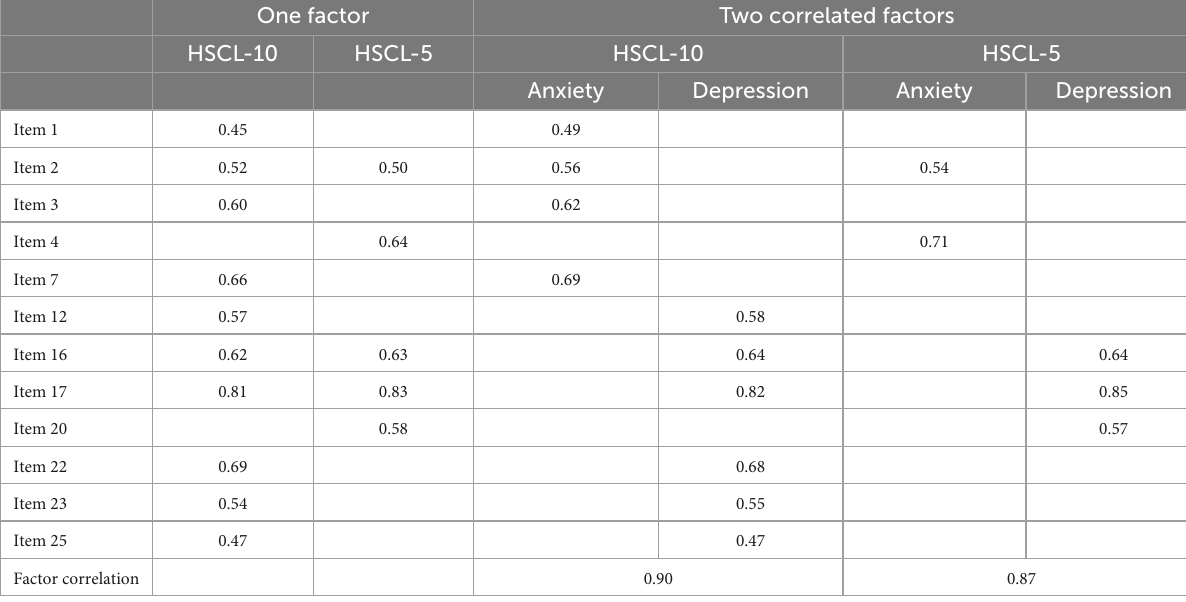
TABLE 4 Confirmatory factorial analysis: Factor loading values and correlation between two anxiety and depression factors.